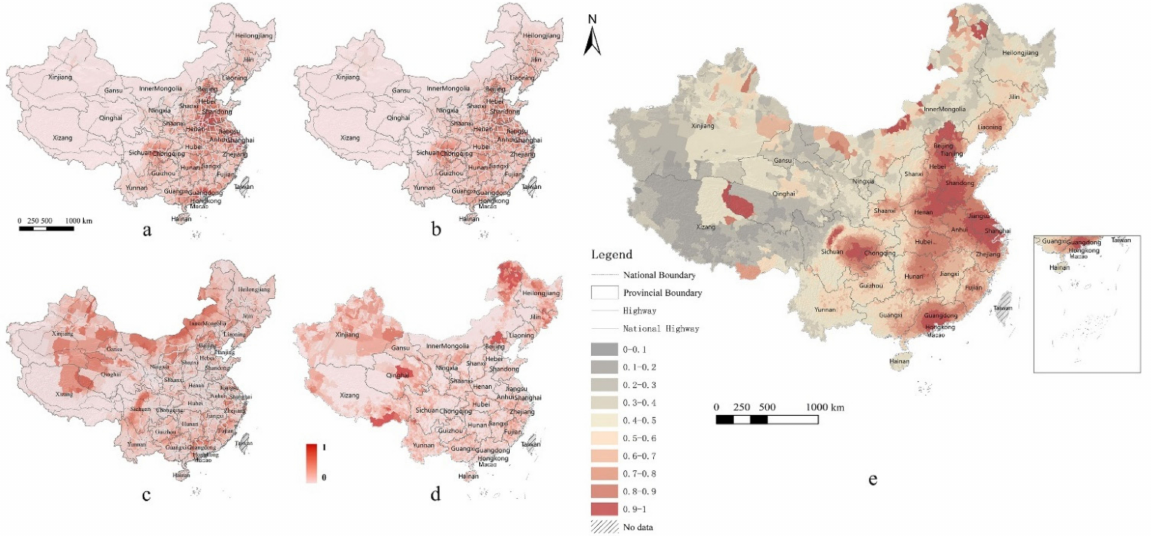
Figure 4. The sustainability evaluation results of the HM dimension. The evaluation results of ( a ) the total population, ( b ) the aging population, ( c ) the per capita GDP, and ( d ) scenic spots; ( e ) the DI of the HM